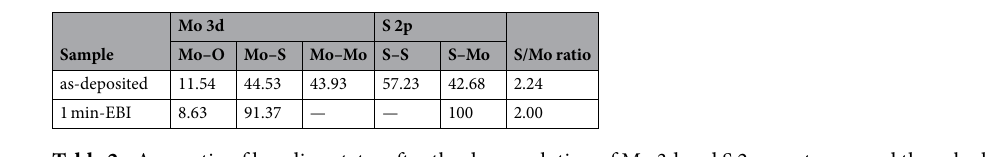
Table 2. Area ratio of bonding states after the deconvolution of Mo 3d and S 2p spectrums and the calculated value of the S/Mo ratio from the as-deposited and 1 min EBI-treated